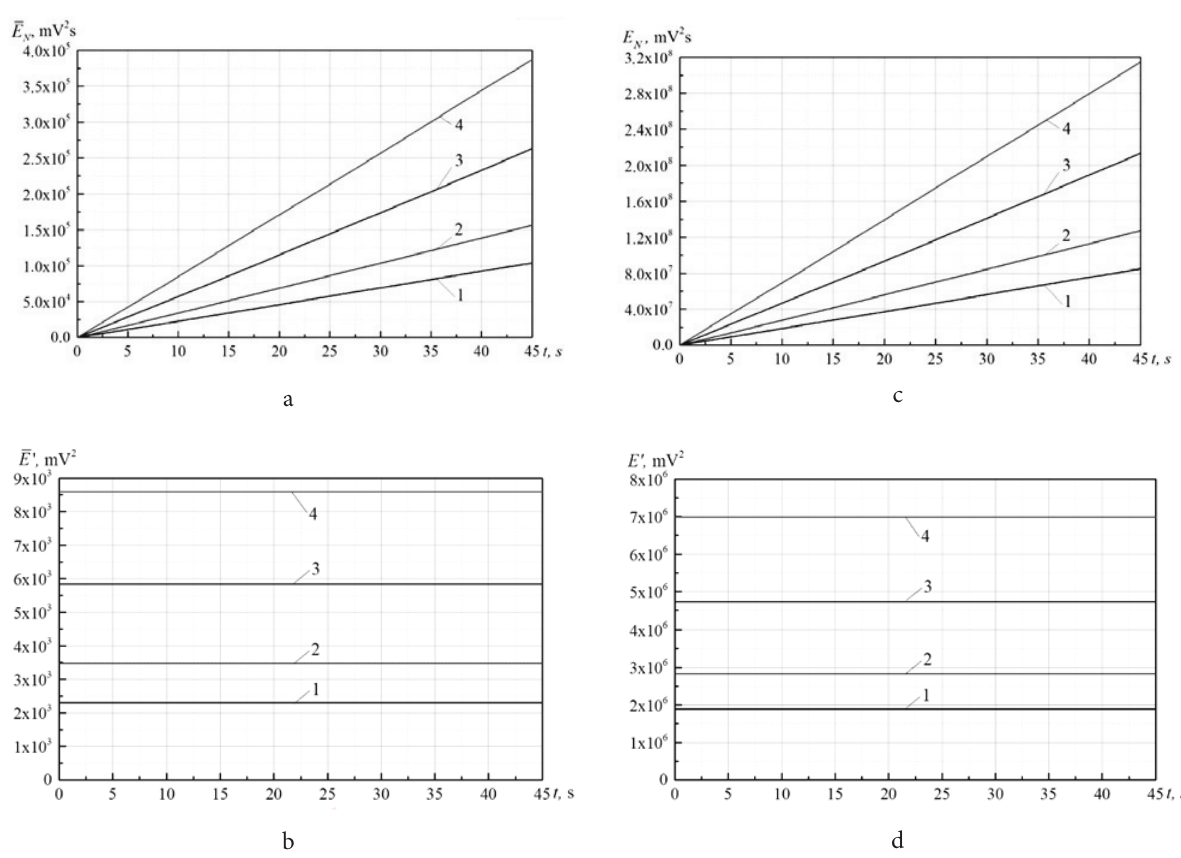
Fig. 5. Accumulated average energy N E ( a ) and accumulated total energy N E ( c ) of acoustic emission signals; the rate of accumulated energy ' E and the rate of accumulated energy E' ( b , d ), which were recorded at different rotational speeds v at a normal stage of wear of a friction pair with a coating made of composite material. The rotational speeds of friction pair v are the following: 1 – 500 min –1 , 2 – 600 min –1 , 3 – 700 min –1 , 4 – 800 min –1 . The axial loading on a friction unit is taken as P = 450